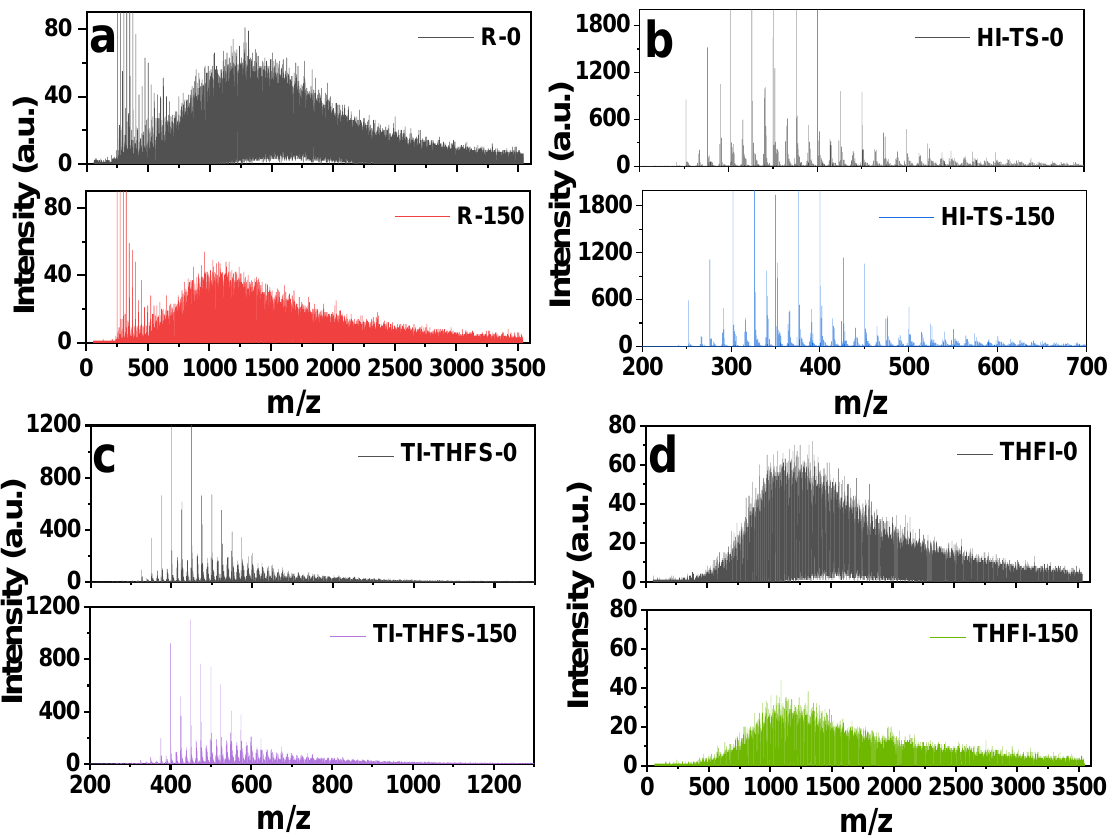
Figure 1. Molecular weight distribution of different spinnable pitch fractions before and after 150 days